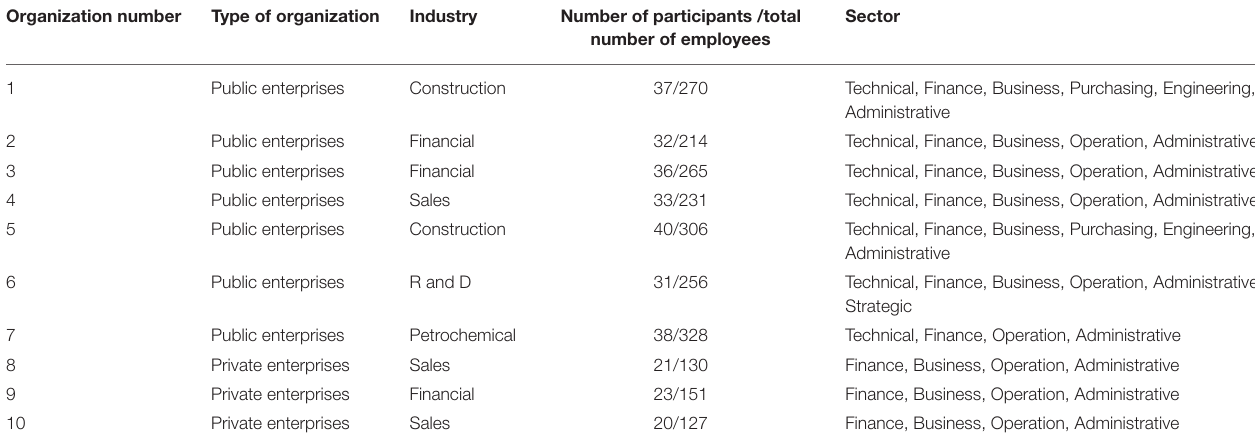
TABLE 1 | Sample distribution characteristics of